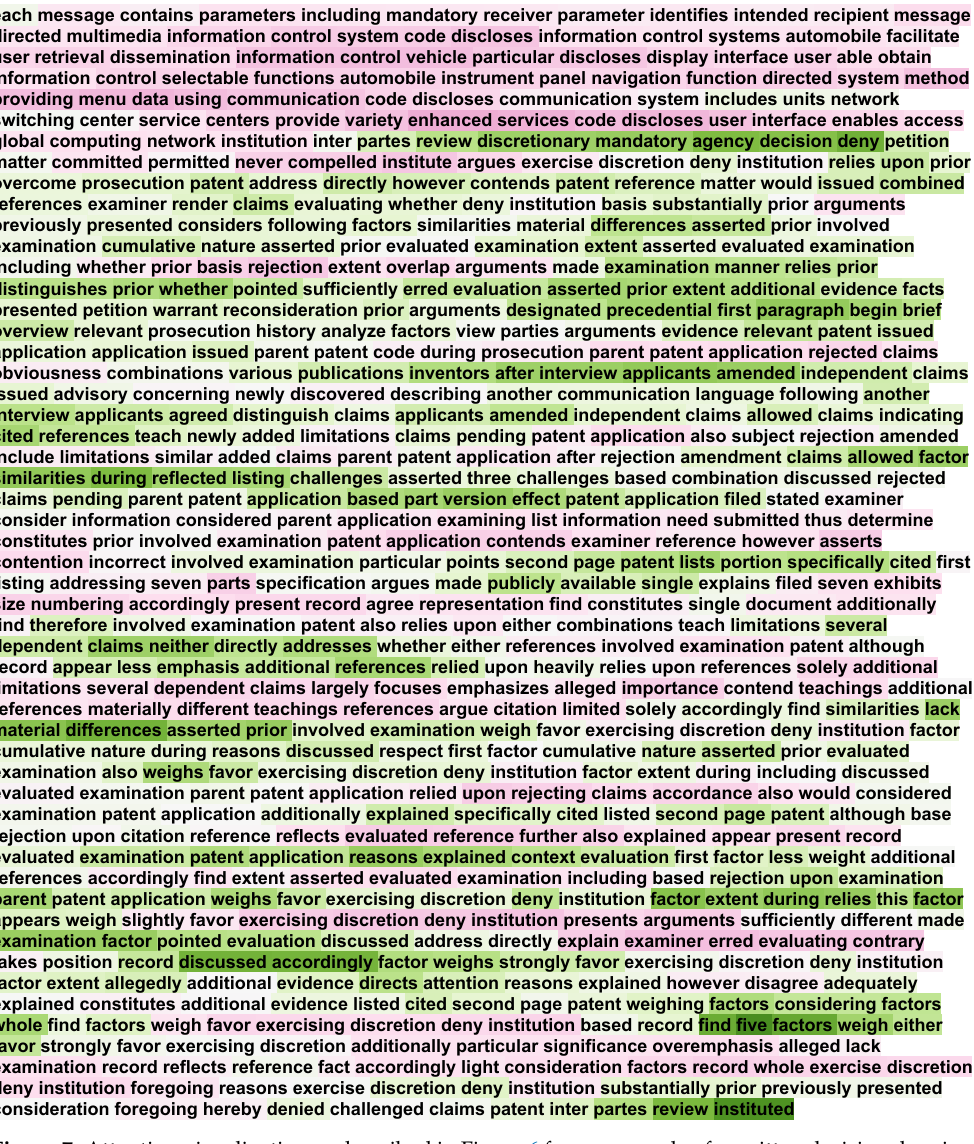
Figure 7. Attention visualization as described in Figure 6 for an example of a written decision denying institution in case number IPR2019-00839, filed 20 March 2019 by Microsoft Corporation against IPA Technologies Inc. Green-labeled words are locations where the attention (for the CNN module with kernel width 8) is greater the median for the sample (excluding the attention at zero tokens where the text was padded), with more intense green corresponding to higher levels of attention. Pink-labeled words are locations where attention is below the sample of the median, and more intense pink corresponds to lower attention at that location in the